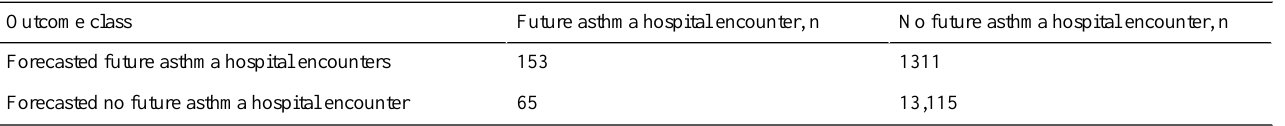
Table 6. The confusion matrix of our final University of Washington Medicine model when the cutoff point for making binary classification was placed at the top 10% (1464/14,644) of patients with asthma with the largest forecasted risk.